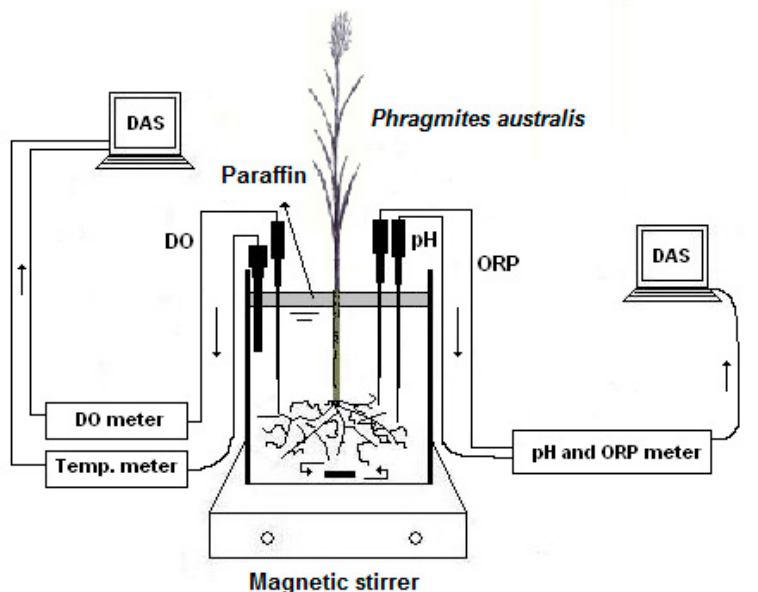
Figure 1. Schematic representation of the experimental set-up (DAS: data acquisition systems; ORP: oxidation-reduction potential; DO dissolved oxygen).